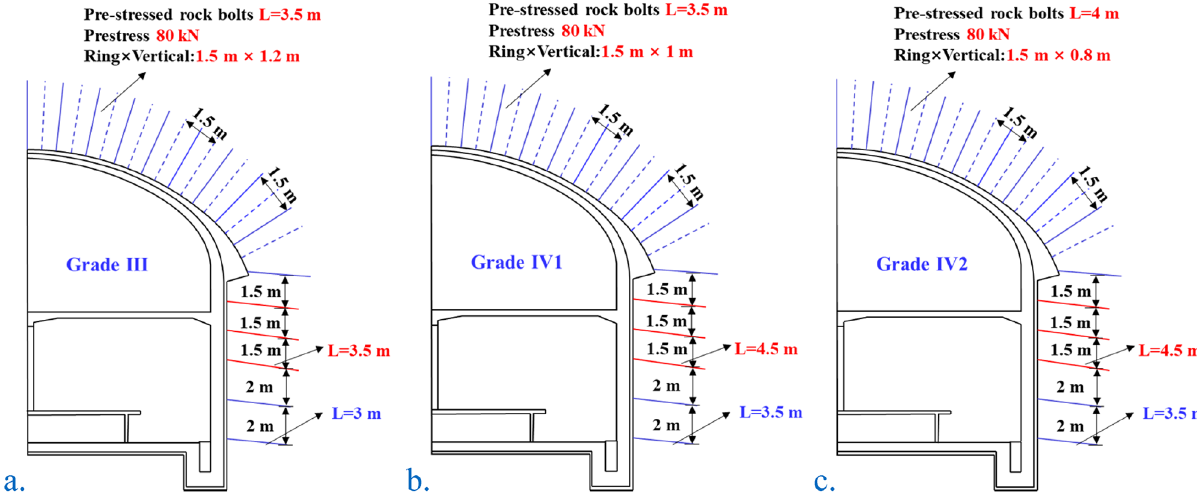
Figure 17. Supporting design drawings of surrounding rock of different